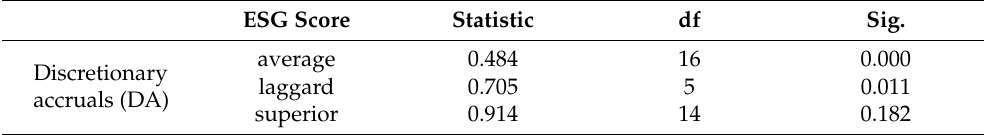
Table 9. Shapiro–Wilk normality test. ESG Score df